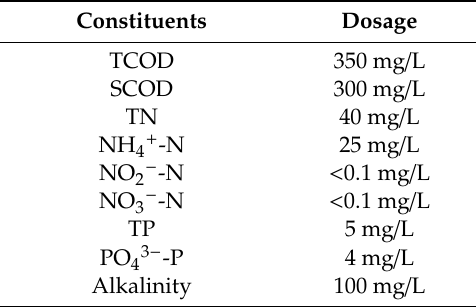
Table 3. The concentration of synthetic wastewater.